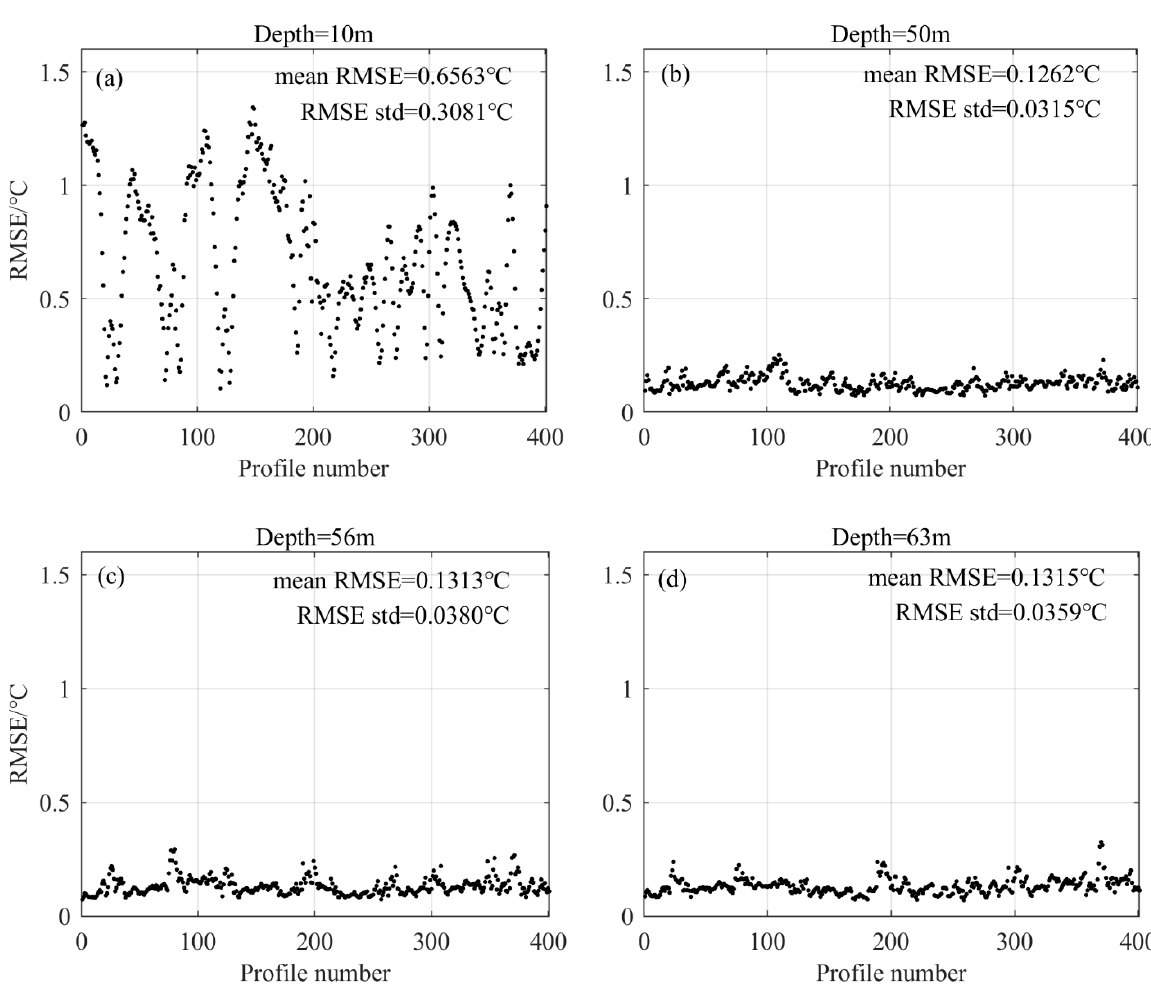
Figure 10. The influence of temperature at different depths as the input data on the inversion results. The depths of ( a – d ) are 10 m, 50 m, 56 m, 63 m, respectively. It is conceivable that with the increase of the input information, the inversion accuracy of the temperature profiles will be improved. Thus, we try to use two or three depth-fixed temperatures as input. As shown in Figure 11, the RMSE of the temperature profile inversion is basically reduced to 0.2 °C. Compared with the inversion results using one depth-fixed temperature as input, the accuracy is significantly improved. When the input data are the temperatures at the extreme point of the first two EOF basis functions, the inversion accuracy is the highest. The mean RMSE in the test set is about 0.11 °C, and the standard deviation is about 0.025 °C.